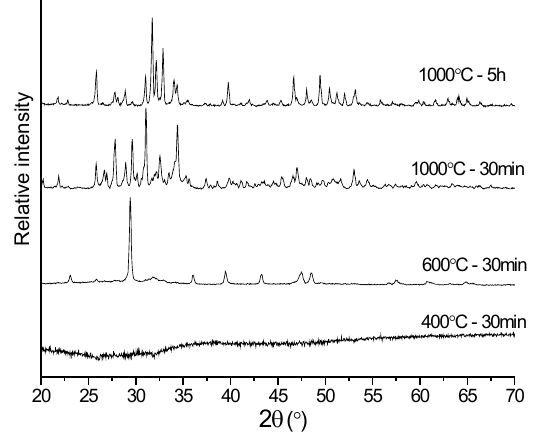
Figure 3. X-ray diffraction patterns of the ceramic products obtained after calcination of Ca-P-O precursor gel derived at pH~10 at different temperatures and duration.